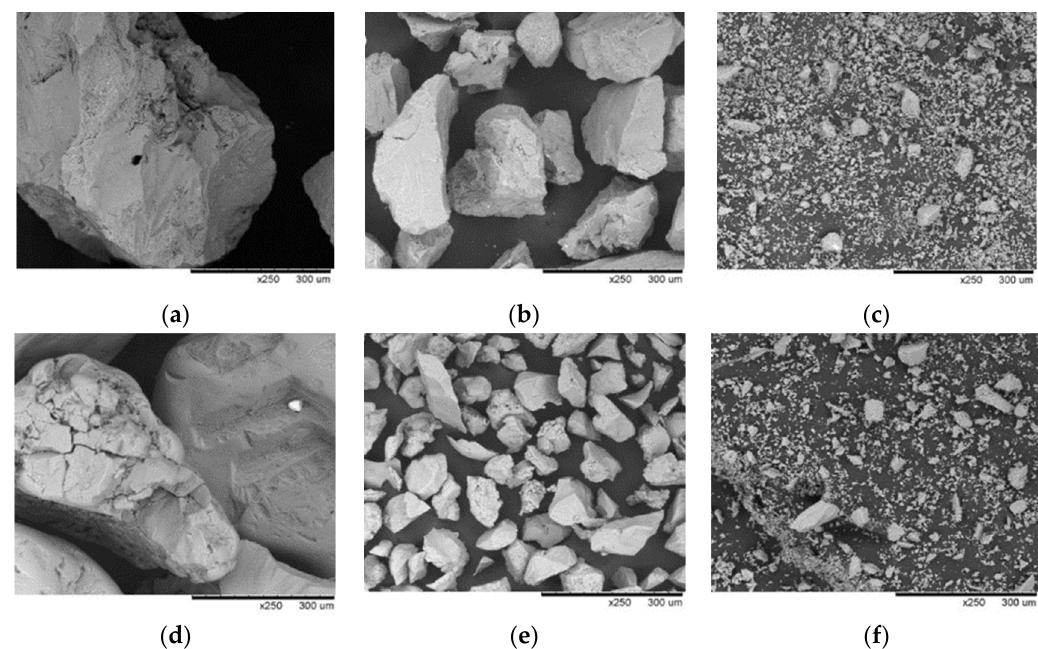
Figure 2. Microstructure of the powder particles used to make the mold samples: molochite sand, 0.5–1.0 mm ( a ); molochite sand, 0.1–0.3 mm ( b ); molochite flour ( c ); quartz sand, 0.5–1.0 mm ( d ); quartz sand, 0.1–0.3 mm ( e ); quartz flour ( f ).